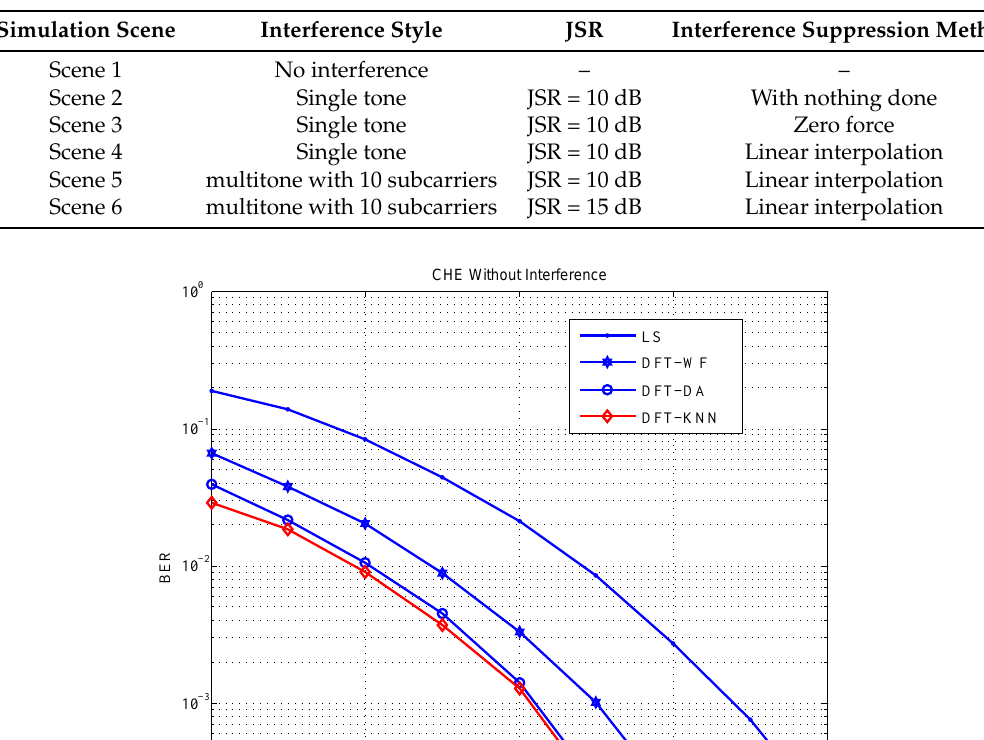
Table 4. Simulation scenes with different interference styles.